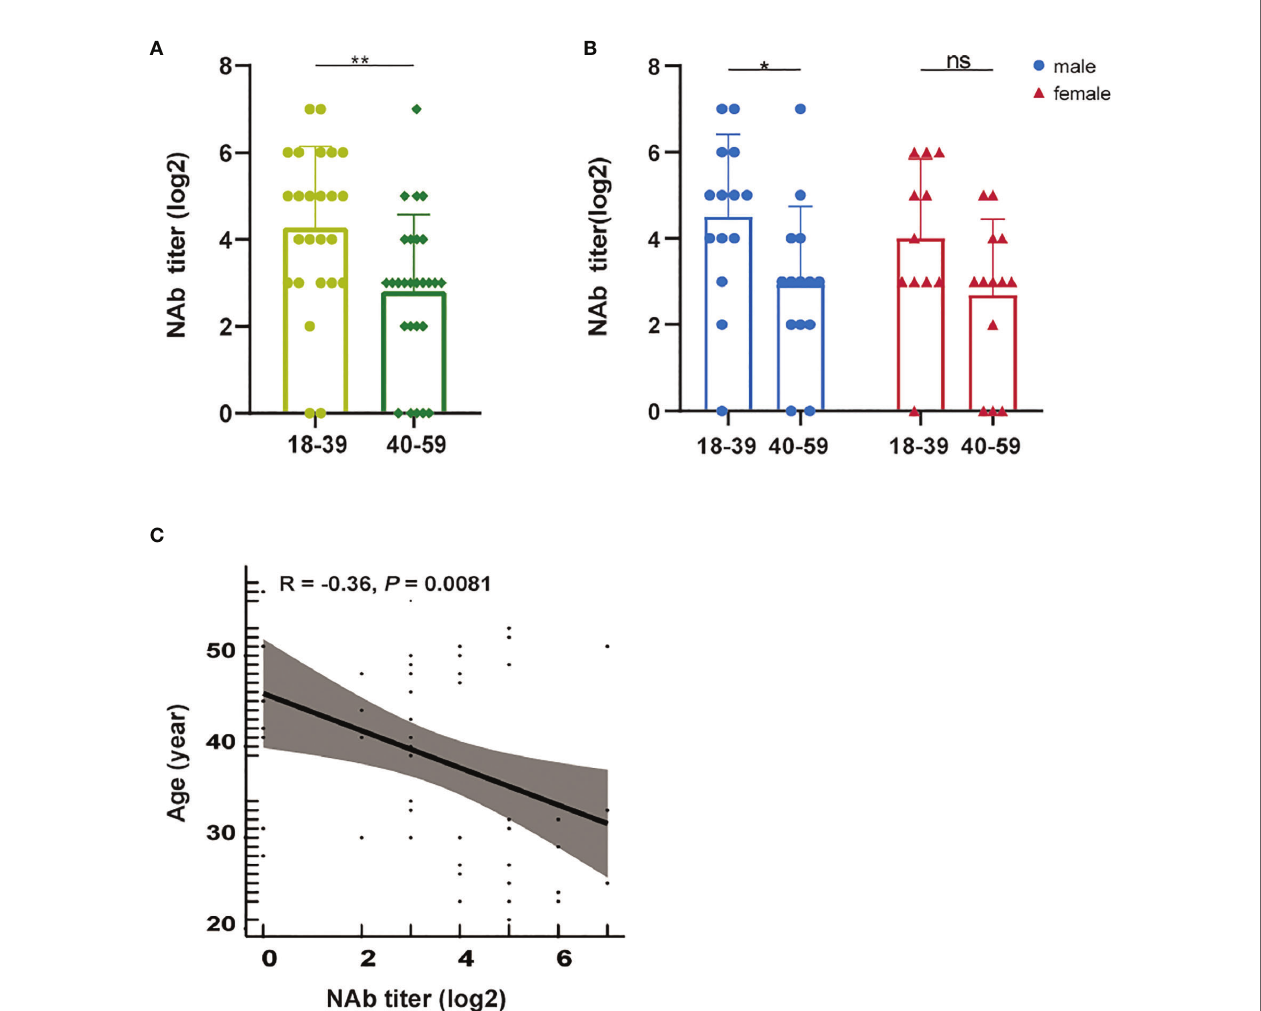
FIGURE 6 | TherelationshipbetweenageandNAbtiterlevels. (A) ComparisonofpeakNAbtiterlevelsbetween18-39-year-oldand40-59-year-oldrecipients. (B) Comparison ofpeakNAbtiterlevelsbetweenthe18-39-year-oldand40-59-year-oldmaleandfemalesubgroups. (C) CorrelationbetweenthepeakNAbtiterandtheageofrecipients.A nonparametricMann-WhitneyUtestwasappliedtoanalyzedifferencesbetweenthetwogroups.CorrelationswereanalyzedbyPearsoncorrelationcoef fi cients.Statistical signi fi canceofthedifferencebetweengroupsisdenotedas*for P <0.05,**for P <0.01.NAb,anti-SARS-CoV-2neutralizingantibody;ns,notsigni fi